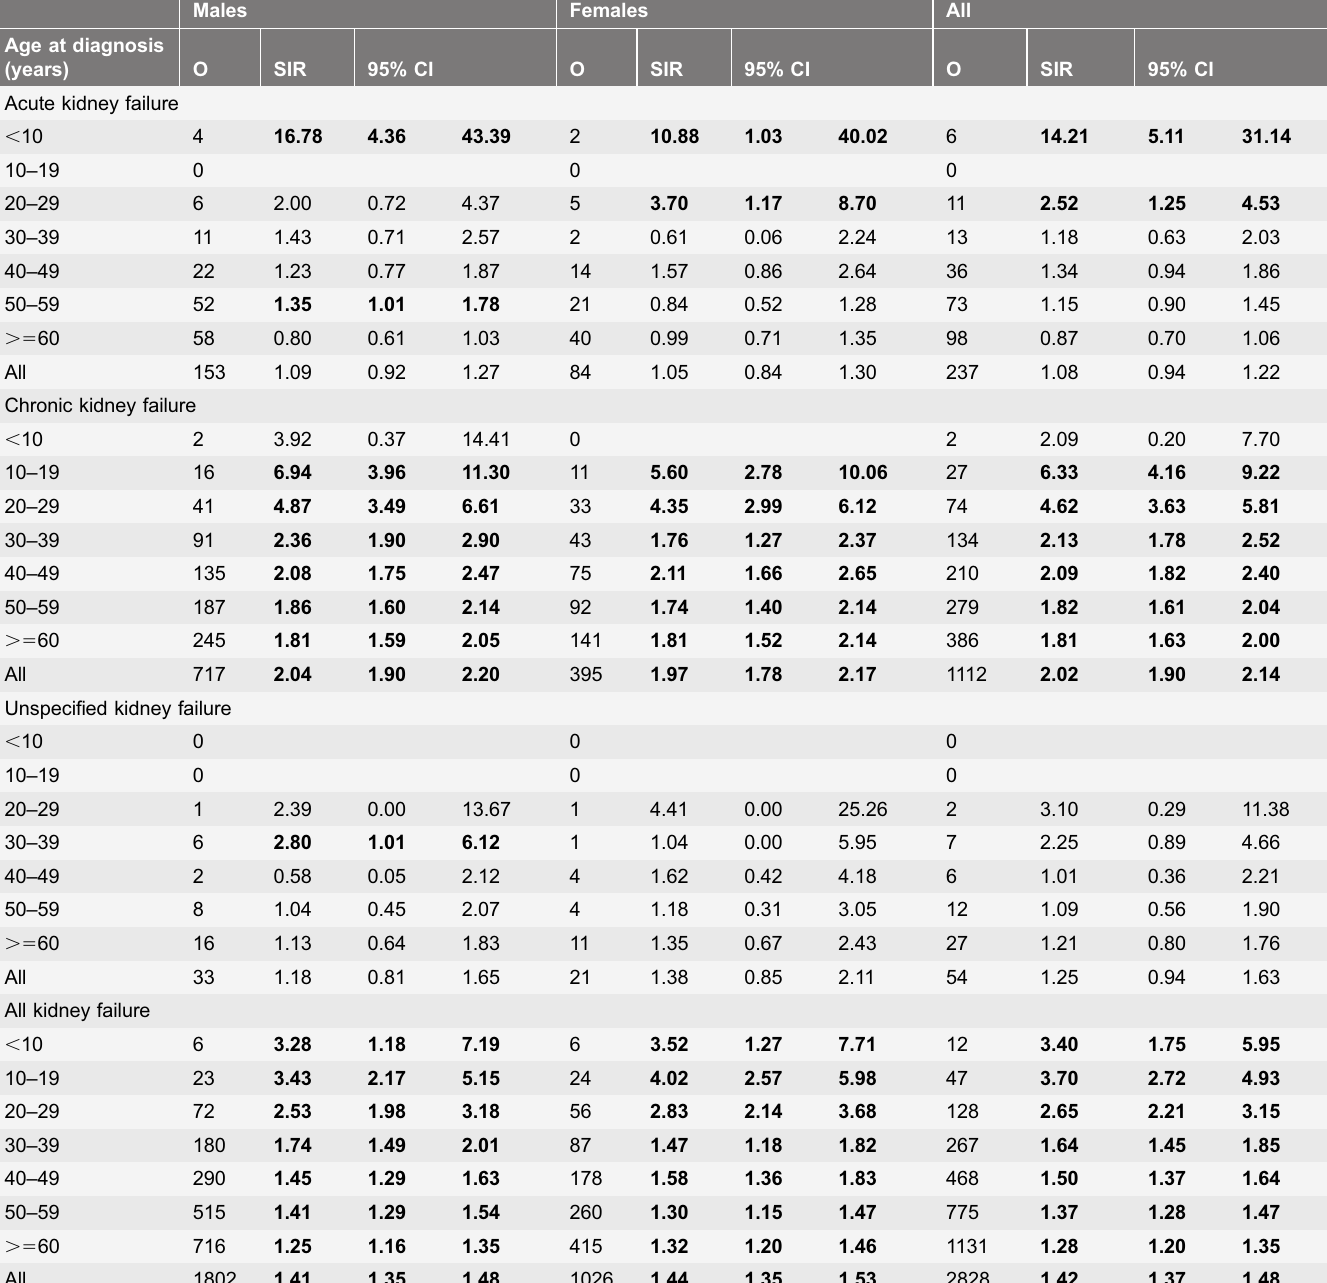
Table 4. Familial risk (sibling/parent history) of concordant kidney failure in males and females by age diagnosis. Males Females